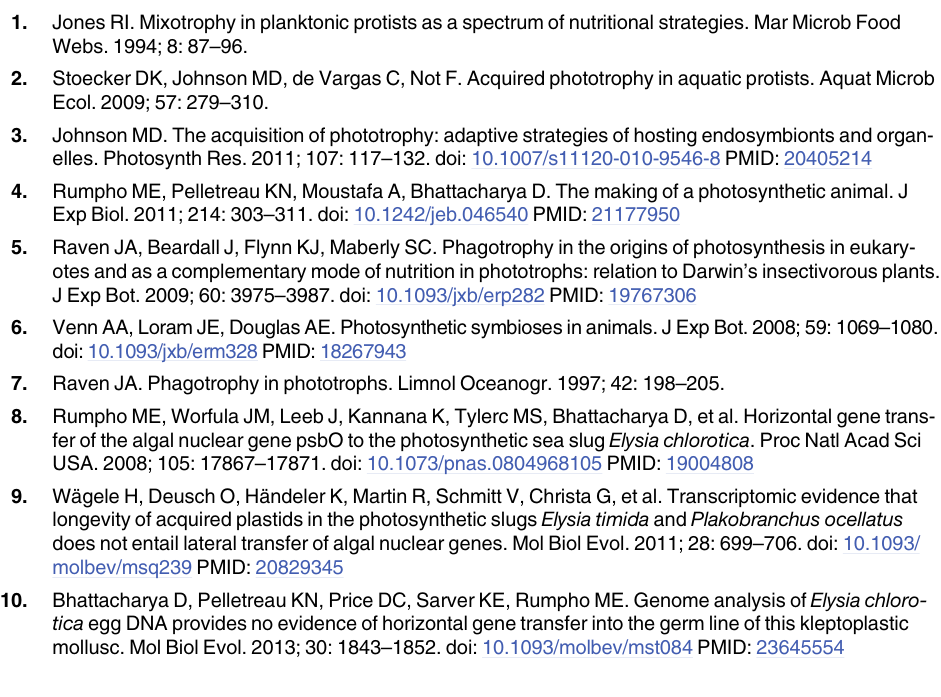
S1 Table. Manuscript raw data. The file includes the raw data underlying the statistical analy- ses and figures in the